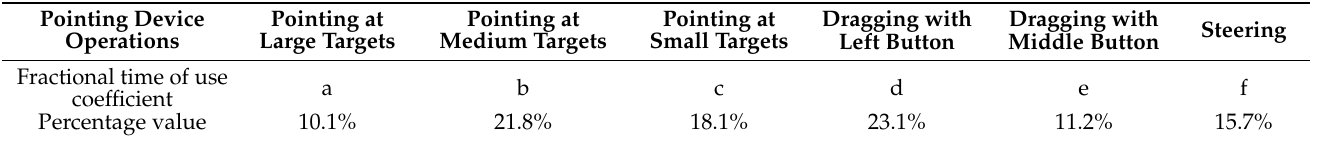
Table 2. Percentage values for fractional time of use coefficients